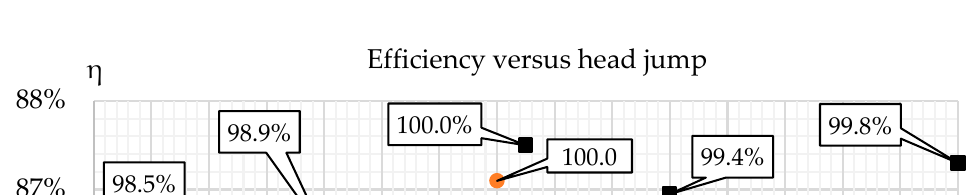
Table 3. Two-dimensional efficiency comparison between UL-PRS1 and PRS turbines for different head jumps.